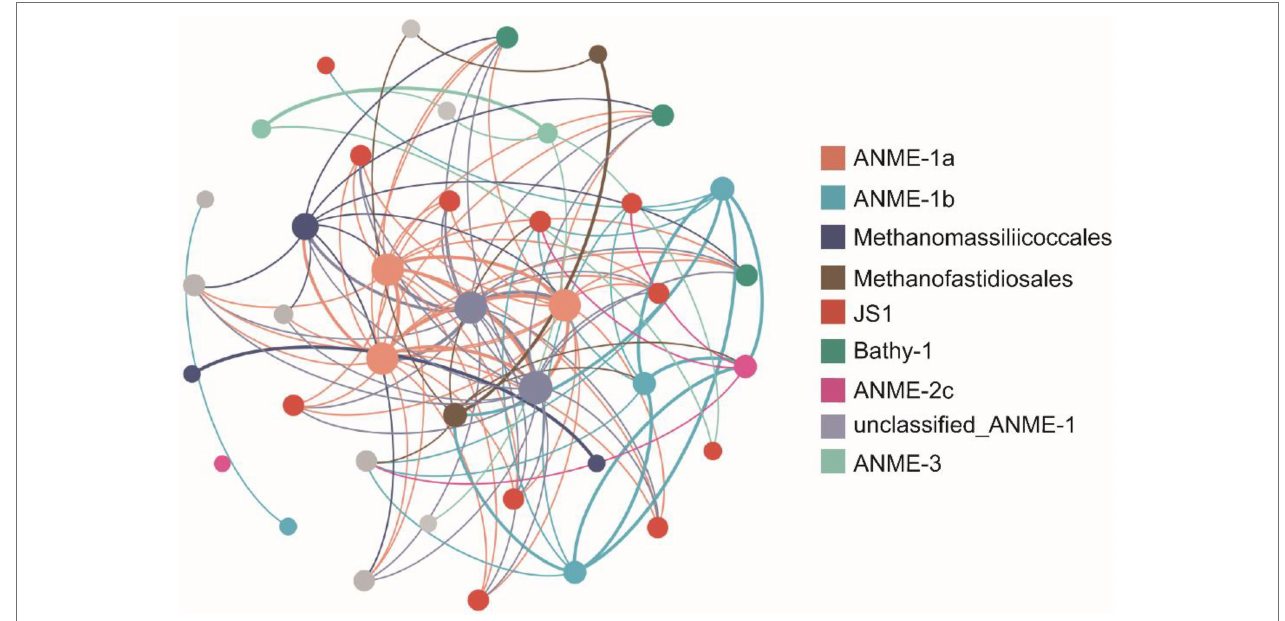
FIGURE 6 | Network co-occurrence patterns of the dominant amplicon sequence variants (ASVs) regarding the relationship of the methane-metabolizing archaea with other microbial taxa in the GC2020-02 core. Only those with a Pearson coefficient > |0.75| and a value of p < 0.005 between ASVs are shown in the figure to reduce complexity. A node represents an ASV, and the node size reflects the number of connections the ASVs have with other ASVs. Edges are colored according to the colors of the nodes that they link, and the edge thickness indicates the strength of the